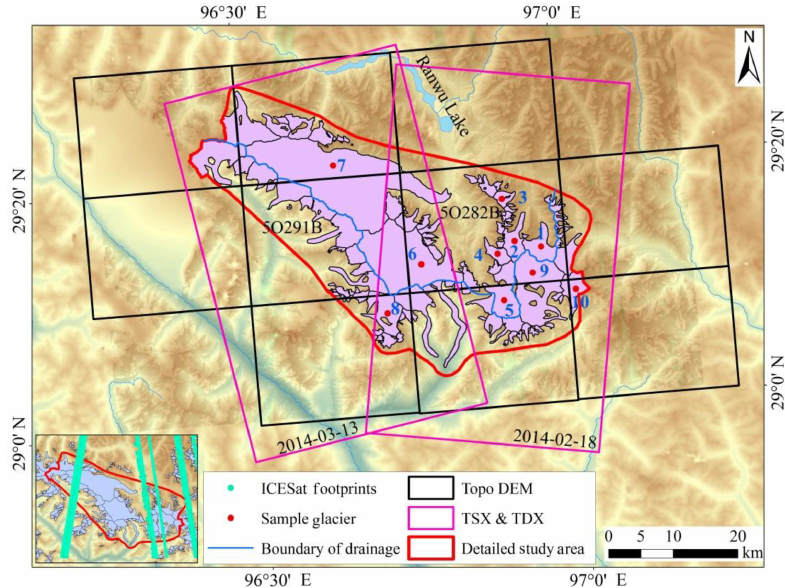
Figure 2. TOPO DEMs, TSX/TDX acquisitions and ICESat footprints. Numbers indicate specific sample glaciers. 5O282B and 5O291B are the drainage basins on the northern and southern slopes of the Kangri Karpo. Table 1. Overview of satellite images and data